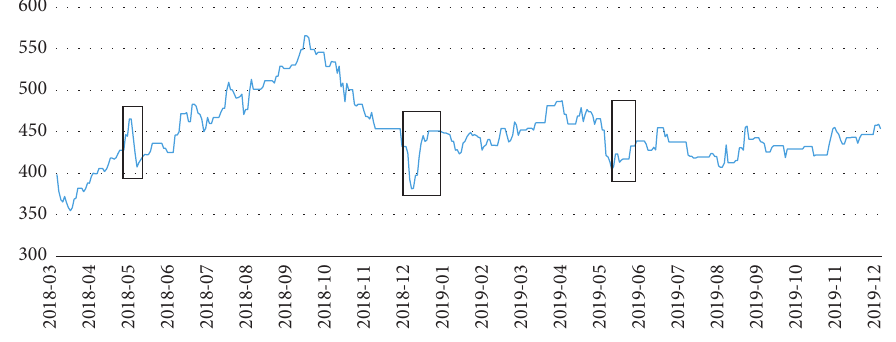
Figure 8: Shanghai crude oil futures real price